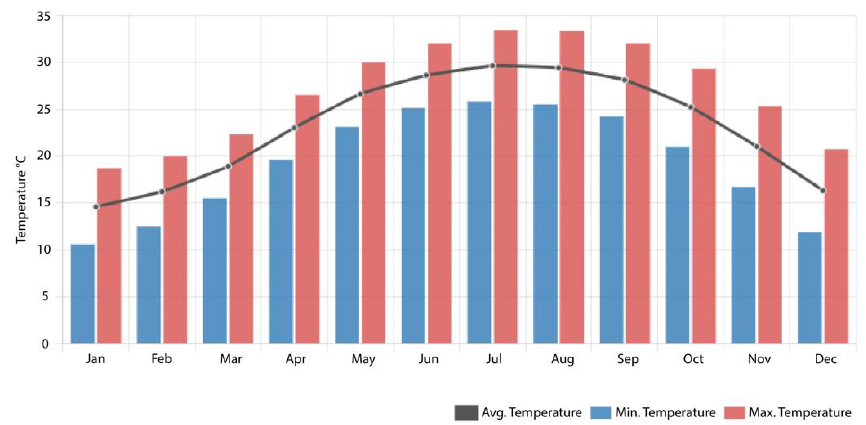
Figure 6. Average monthly temperature, 1991 – 2020.